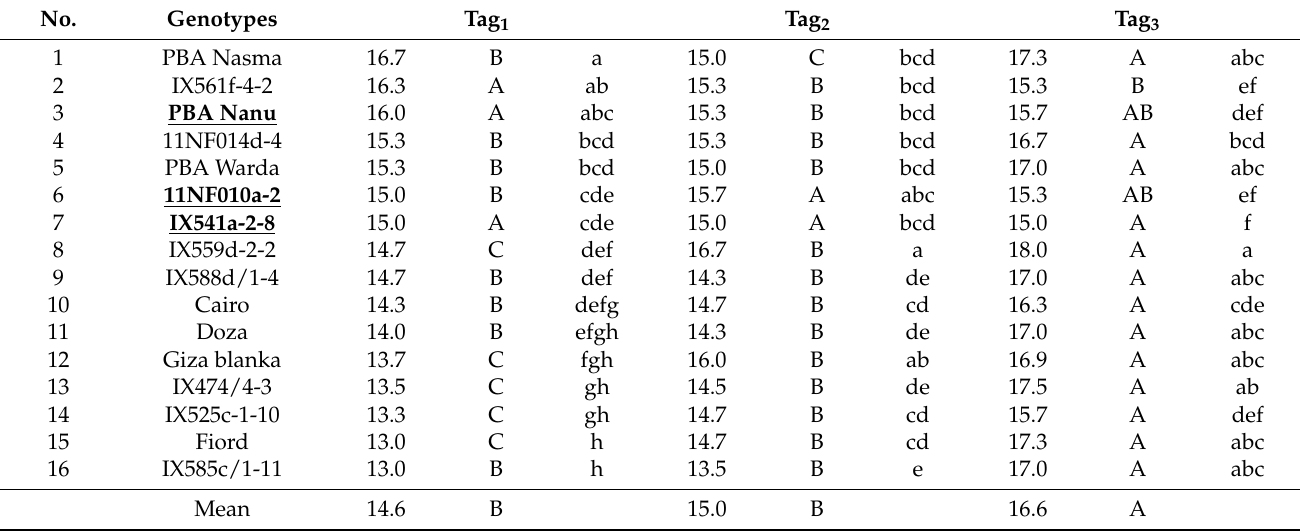
Table 3. Time taken from flowers to produce pods in all tags (Tag 1 , Tag 2 and Tag 3 ) in 2016/2017 at the Agricultural Research Station at Dirab ( n = 3). Means denoted by different capital letters are significantly different among time of tagging (l.s.d. = 0.5 ***), and small letters among genotypes within each time of tagging (l.s.d. = 1.1 *). Bold/underline genotypes show those where they took 15 − 16 days to produce pods from the tagged